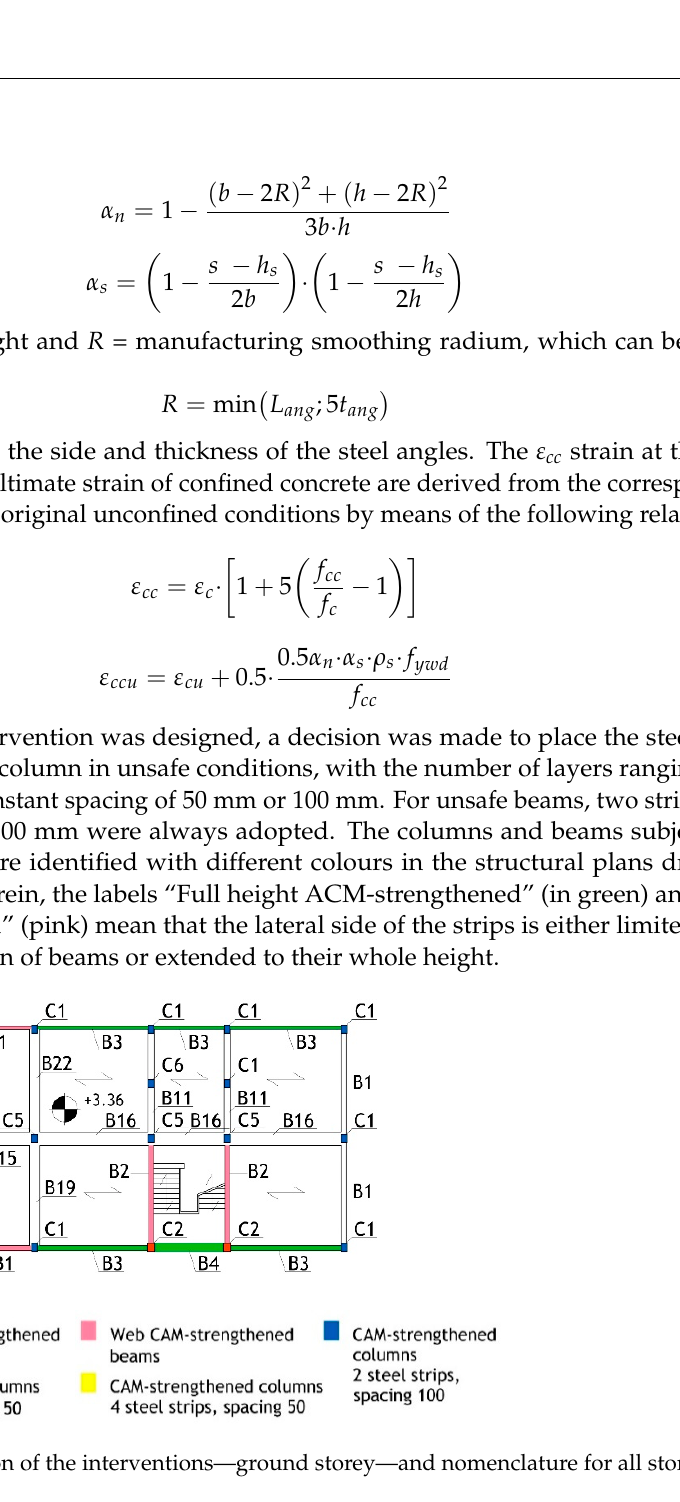
Figure 15. Localization of the interventions—second storey. Figure 16. Localization of the interventions—third storey. The f cc , ε cc , and ε ccu values computed by means of Formulas (1), (5), and (6), respec- tively, are recapitulated in Table 1, for the columns subjected to the intervention, and Ta- ble 2, for beams. The f cc values are about 10% to 50% greater than the f c value of 20.3 MPa identified in current conditions, as mentioned in Section 2.1; at the same time, ε cc and ε ccu are about 180% to 415% greater than the corresponding ε c and ε cu values of 0.00156 and 0.00402, respectively, cited in Section 2.1 as well. Table 1. Mechanical parameters of confined concrete—columns. Column Type